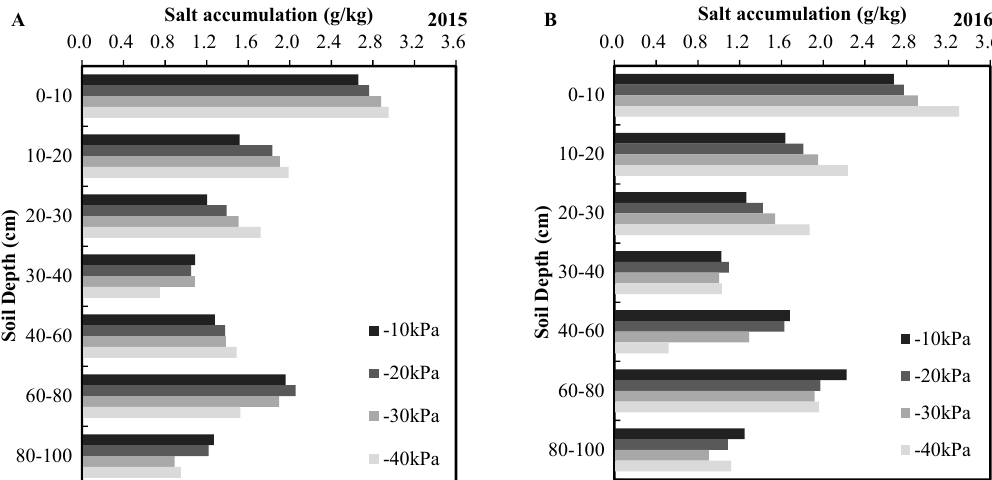
Figure 10. Soil salt (g · kg − 1 ) accumulation for saline water irrigation: ( A ) soil salt (g · kg − 1 ) accumulation in 2015; ( B ) soil salt (g · kg − 1 ) accumulation in 2016.